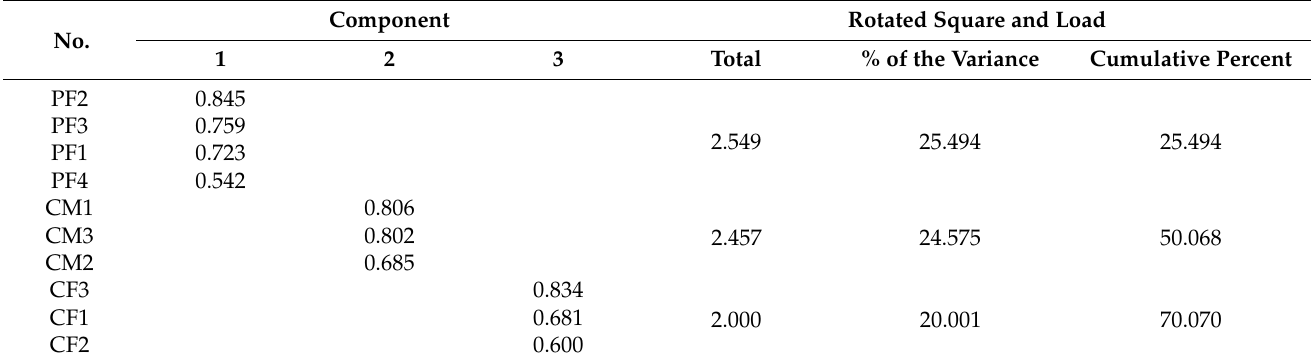
Table 5. Rotated